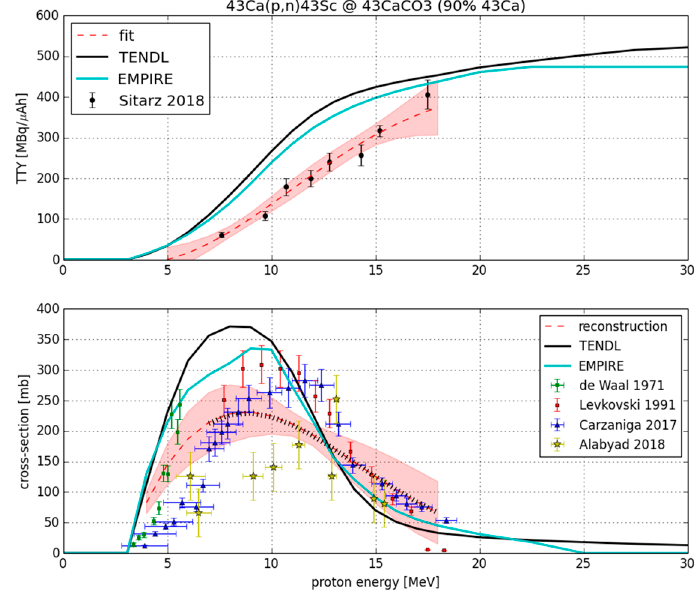
Figure 1. Reconstruction of 43 Ca(p,n) 43 Sc cross-section (bottom) based on the fit to TTY data on 43 CaCO 3 enriched in 90% 43 Ca (top). The cross-section data points are taken from [26,31,33,34].